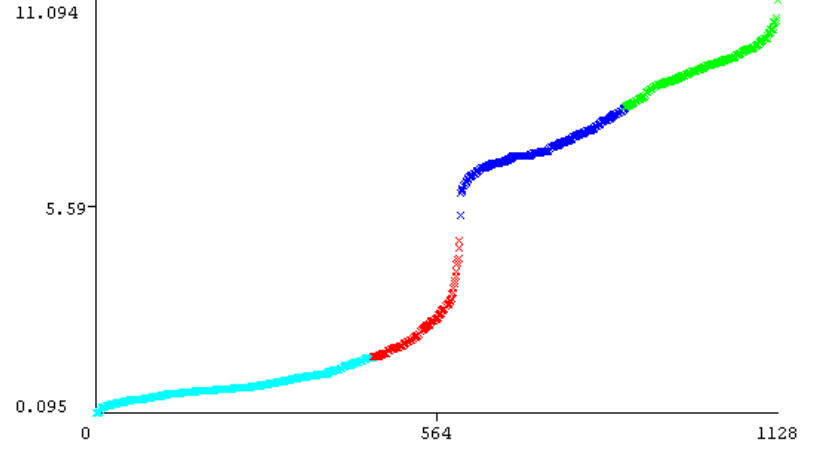
Figure 2. ln(x+1) clustering by SimpleKMeans, where x is Ni concentration data expressed in ppm. Four clusters can be observed: cluster 3 (cyan), cluster 1 (red), cluster 0 (blue) and cluster 2 (green). Y-axis shows the value of ln(x+1), whereas X-axis shows the number of the instance (the order of Ni datum in the original data file, where values were ordered from lowest to highest).